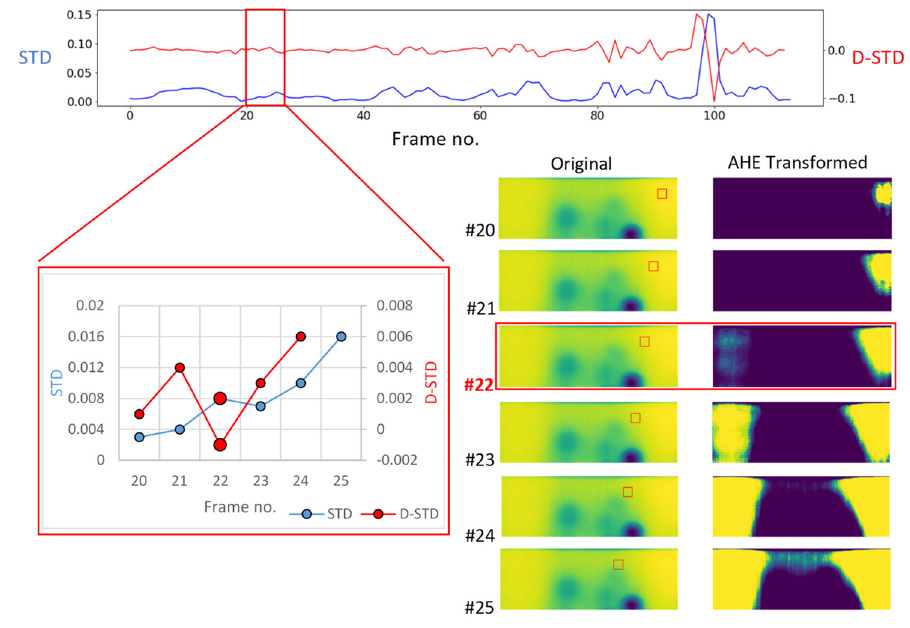
Figure 8. Trend of STD and D-STD mapping block transitioning at frame #22.